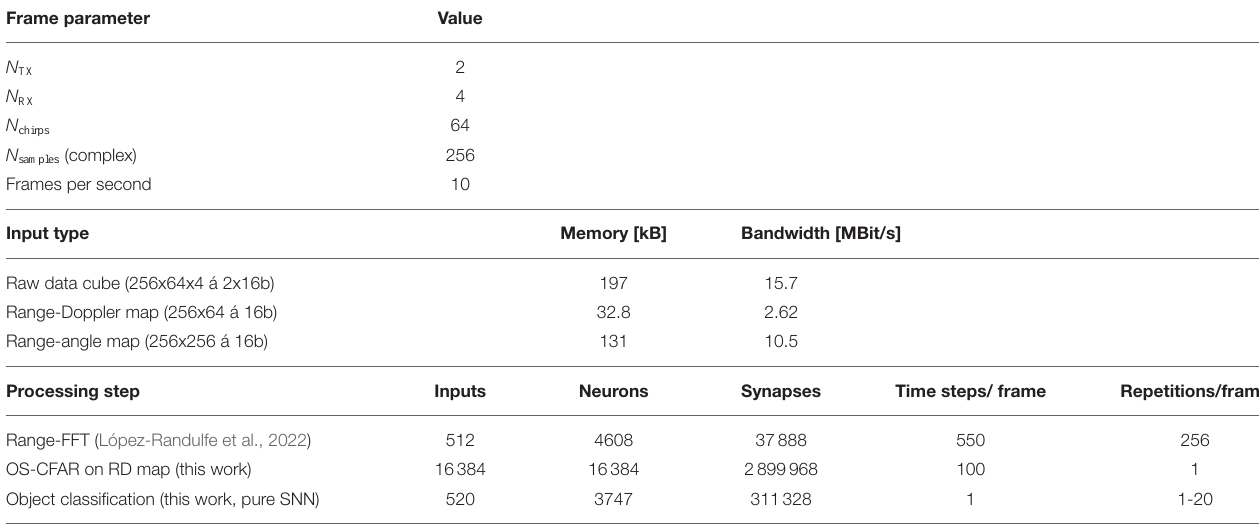
TABLE 3 | Requirements for a neuromorphic ASIC for radar